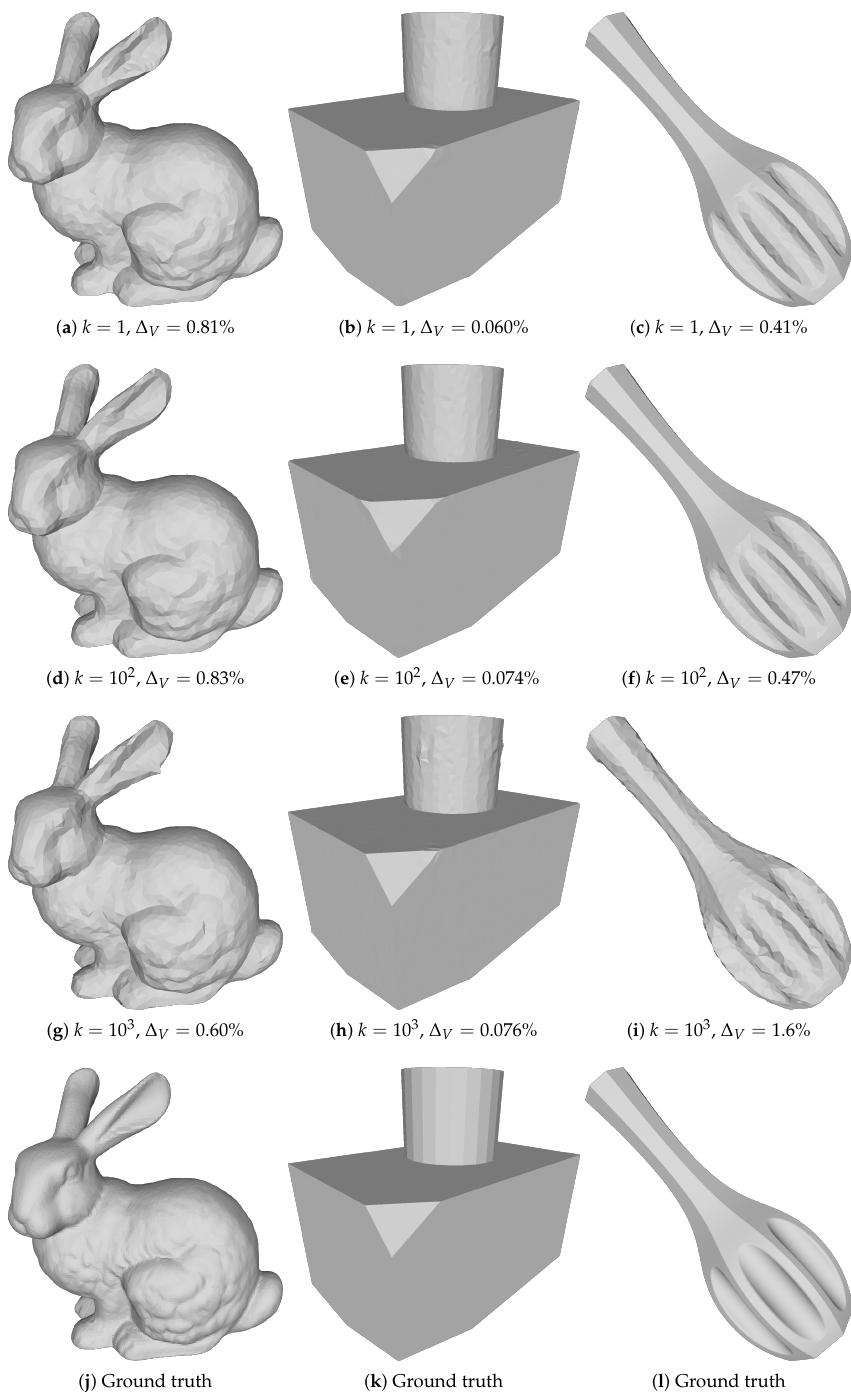
Figure 4. Reconstructions made by our method on three different objects, for increasing levels of Figure 3. Reconstructions made with our method on three different objects, for increasing levels of noise k . noise k